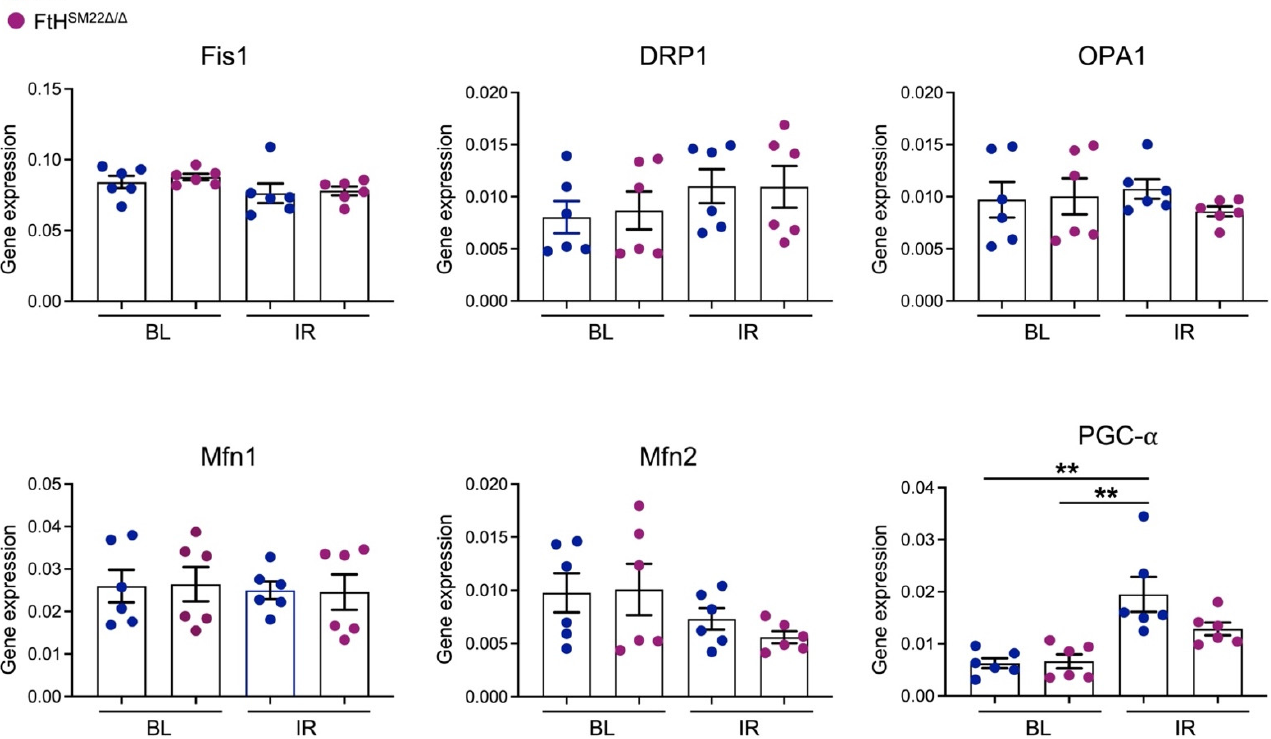
Figure 2. FtH deletion does not alter expression of genes involved in mitochondrial fission and fusion processes following ischemia-reperfusion (IR). RNA from the left ventricle of FtH fl/fl and FtH SM22 ∆ / ∆ mice under baseline (BL) conditions and the ischemic region at 3 h post IR was isolated and expression levels of fission and fusion genes as well as PGC-1 α were examined using RT-PCR analysis. Results were normalized to GAPDH and presented as means ± SEM. n = 5/condition/genotype. ** p < 0.01.